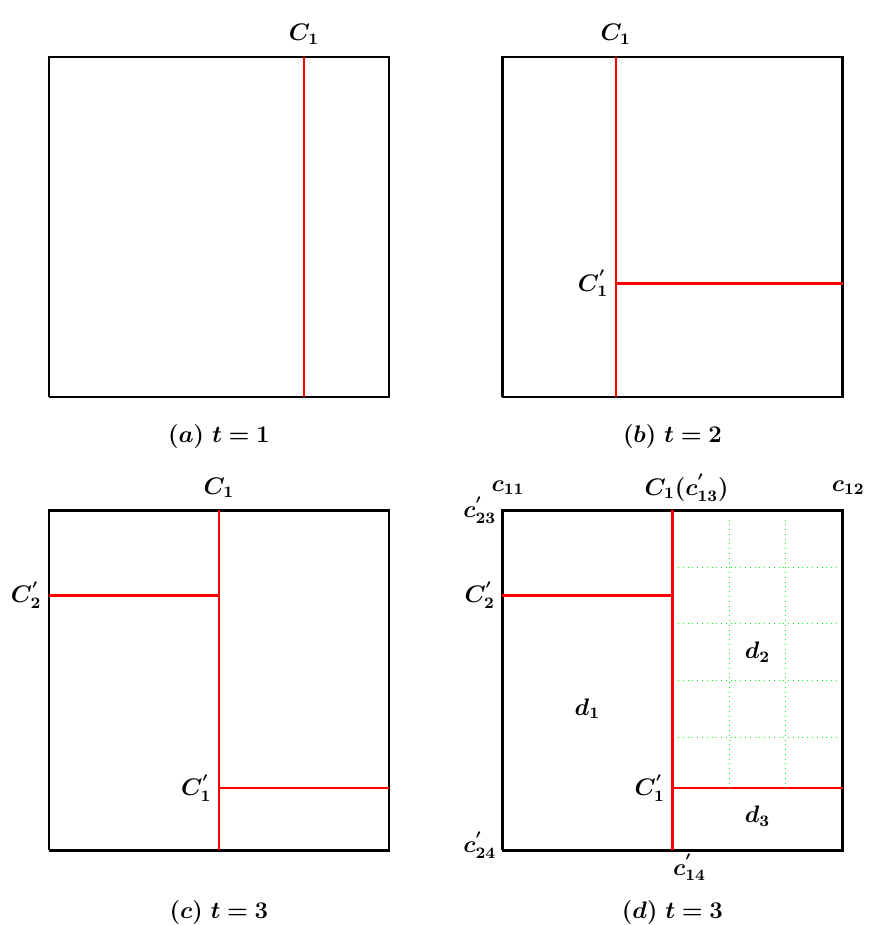
Figure 1. ( a ) shows the first iteration starting with a random vertical cut C 1 . ( b ) shows the second iteration where C 1 is moved to left and a new horizontal cut C (cid:48) is inserted. We keep vertical and 1 horizontal cuts seperately to avoid label switching problem. ( c ) shows the third iteration where C 1 and C (cid:48) are moved to their new positions and a new horizontal cut C (cid:48) is inserted. ( d ) illustrates 2 1 possible movements of all cuts for the fourth iteration. The vertical cut C 1 ’s possible leftmost and rightmost movements are c 11 and c 12 , respectively. The horizontal cut C (cid:48) ’s possible uppermost and 1 downmost movements are c (cid:48) and c (cid:48) , respectively. Dotted lines inside the domain d 2 illustrate 13 14 possible vertical and horizontal cuts if it is chosen to be inserted a new